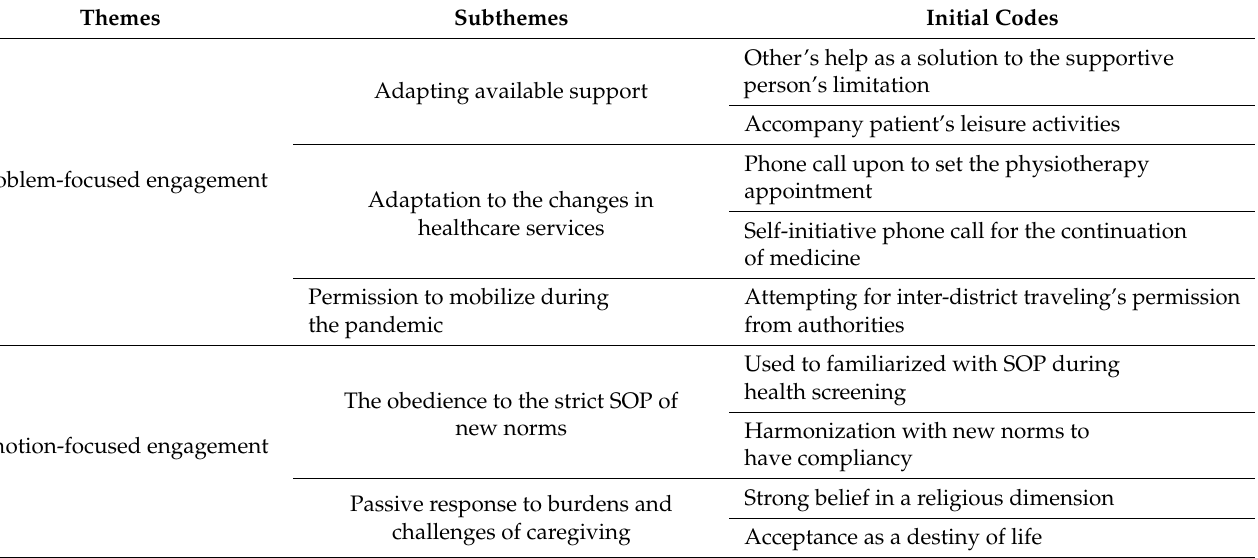
Table A3. Subthemes and themes on coping strategies in managing stroke patients during the pandemic of